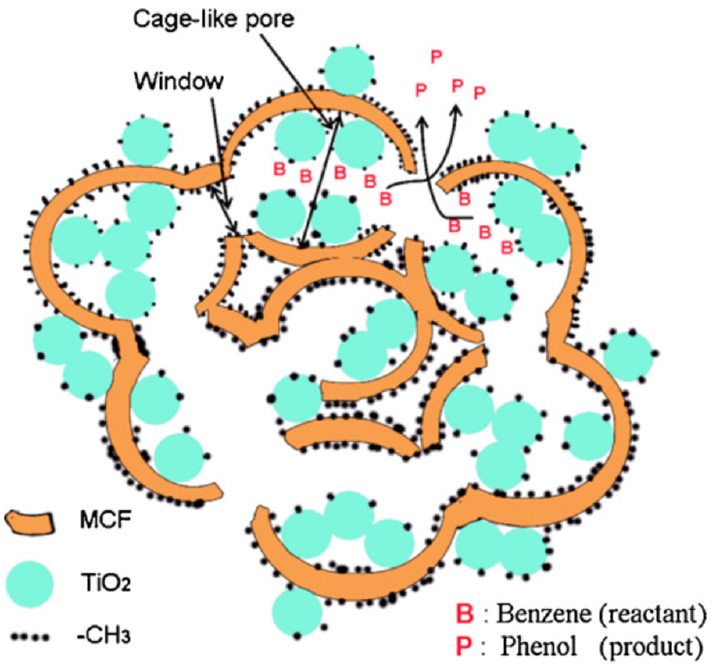
Figure 3. TiO 2 entrapped in the cagelike mesopores of hydrophobically modified MCF for the hydroxylation of benzene. Reprinted with permission from Ref. [34]. 2011 Elsevier.